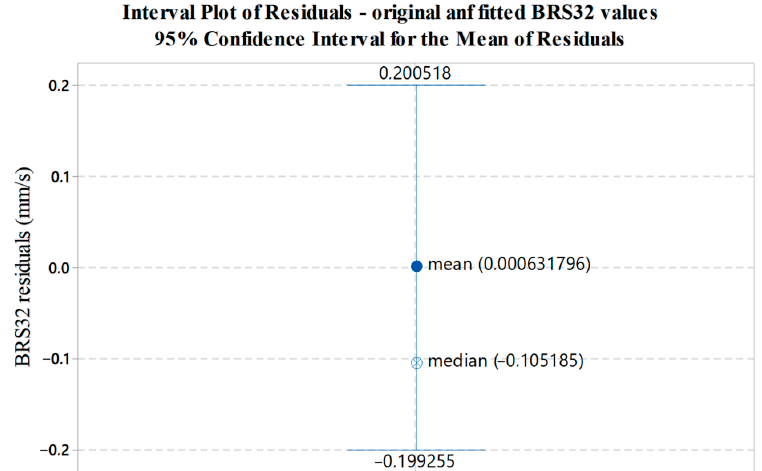
Figure 13. Graphical display of the variability of residuals (errors) between the measured and fitted BRS32 values with respect to data shown in Figure 10.